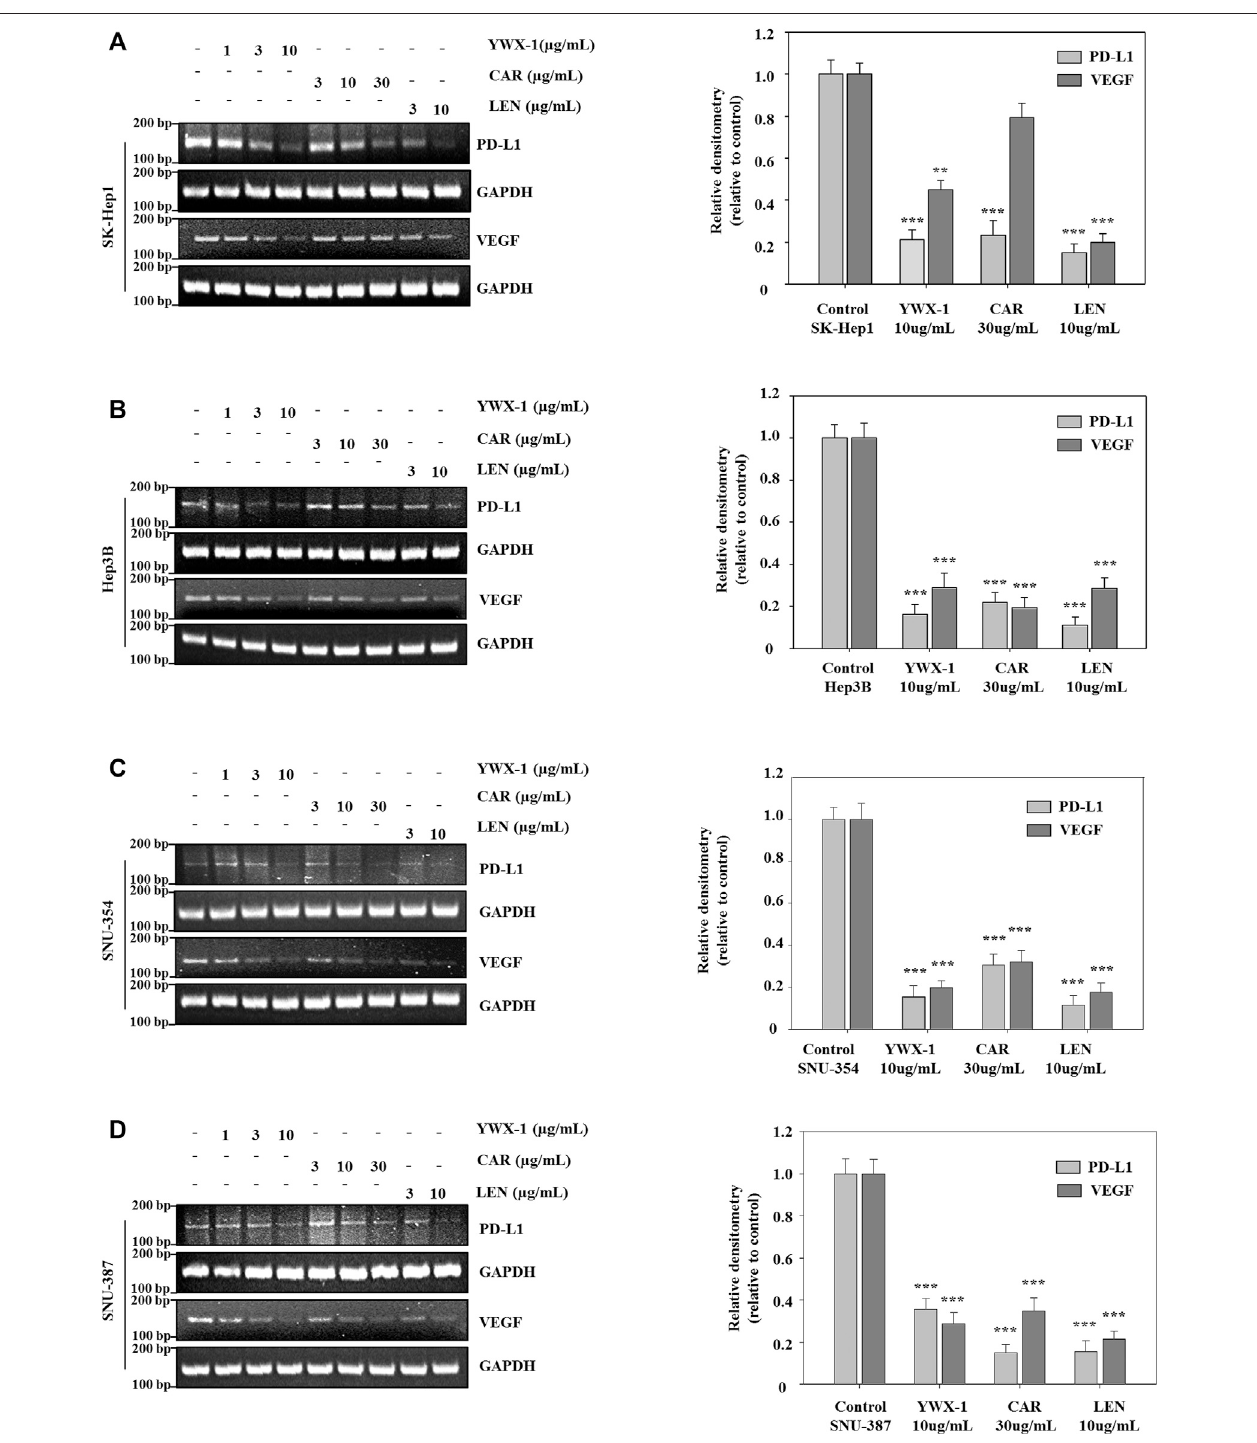
FIGURE 8 | Carrimycin (CAR) and monomeric isovalerylspiramycin I (YWX-1) inhibit the levels of VEGF and PD-L1 mRNA in hepatocellular carcinoma cells. (A – D) SK-Hep1, Hep3B, SNU-354, and SNU-387 cells were treated with different concentrations of carrimycin and monomeric isovalerylspiramycin I. The mRNA levels of VEGF and PD-L1 were analyzed by RT-PCR. GAPDH level was used as a loading control. Statistically signi fi cant differences are indicated when compared with control group: * p < 0.05, ** p < 0.01, *** p < 0.001, Data represented as mean ± standard deviation of three independent experiments (n (cid:2) 3).